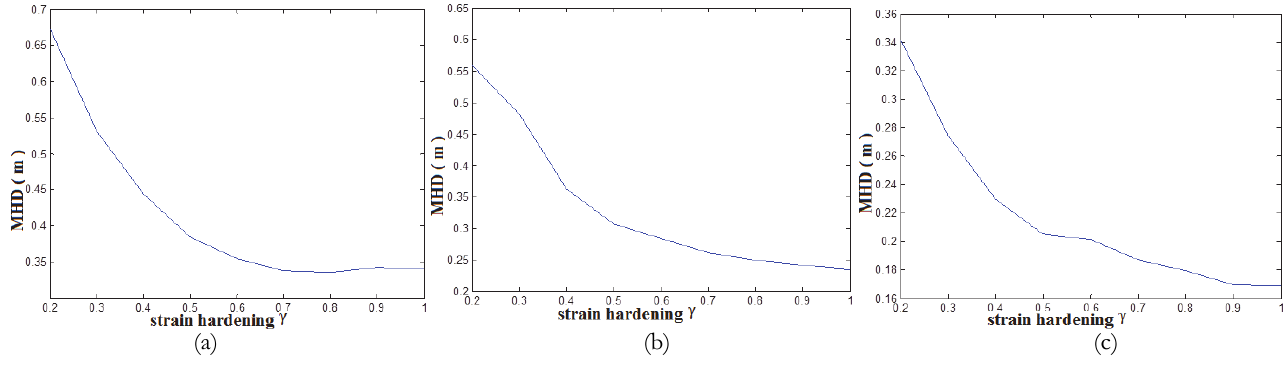
Figure 16: MHD versus variable ( γ ) values under different periods T1, (a) T1 = 1.5 sec; (b) T1 = 1.0 sec; (c) T1 = 0.6 sec. These SMA's parameters depend on variations of other factors, including natural period (T1), seismic records, period ratio ( ρ ), mass ratio ( λ ) and themselves. With the aid of the previously created MATLAP programs of this study, which